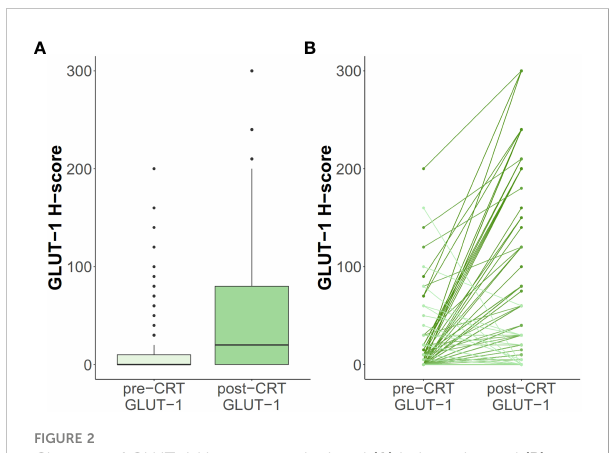
FIGURE 2 Changes of GLUT-1 H-score are depicted (A) in box plot and (B) among individual patients.